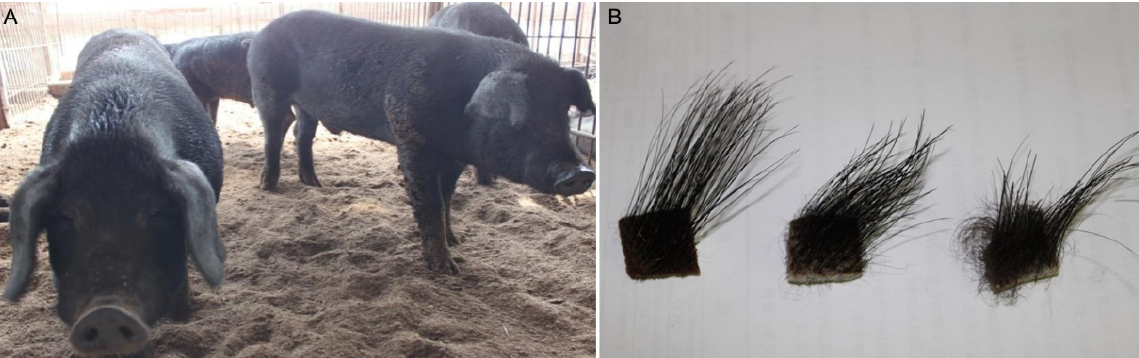
Figure 1. Hair growth of the Min pig. ( A ) coat of a Min pig in winter; ( B ) With the decrease of temperature, the hairs of Min pigs become more dense.